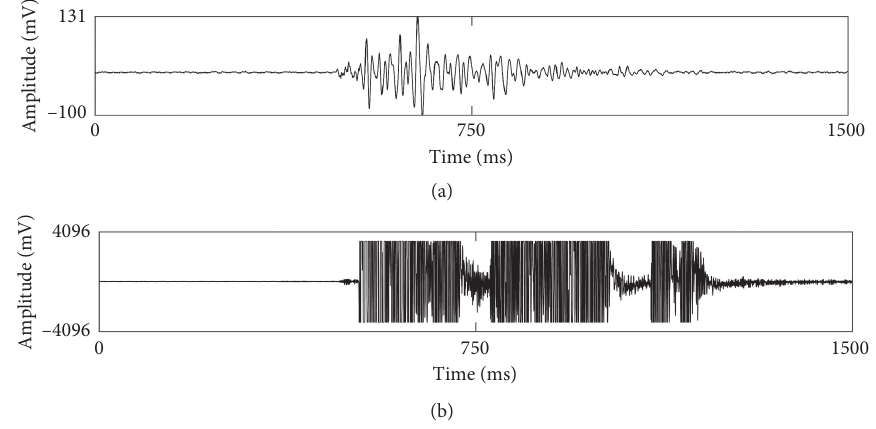
Figure 10: Typical signal waveform: (a) rock microfracture signals; (b) blasting vibration signals.